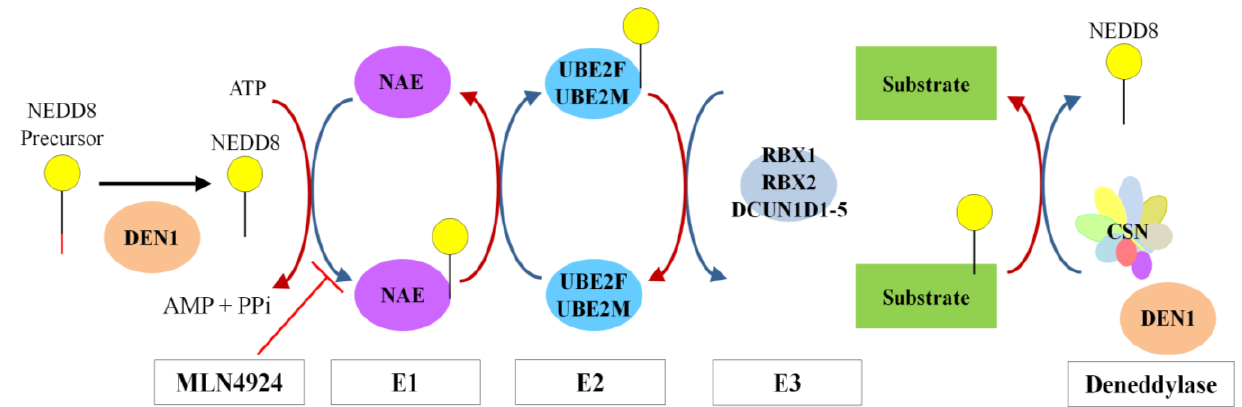
Figure 2. The Neddylation Cascade. A schematic representation of the main proteins in the neddylation cascade. Precursor NEDD8 is processed at the C-terminal to the activated form by DEN1. NEDD8 is conjugated to the target substrate through an E1 (NAE), and E2 (UBE2F or UBE2M), and an E3 (shown are RBX1/2, RNF111 and DCUN1D members). Deneddylation is achieved by the CSN and DEN1. The small molecule MLN4924 inhibits NAE, blocking the